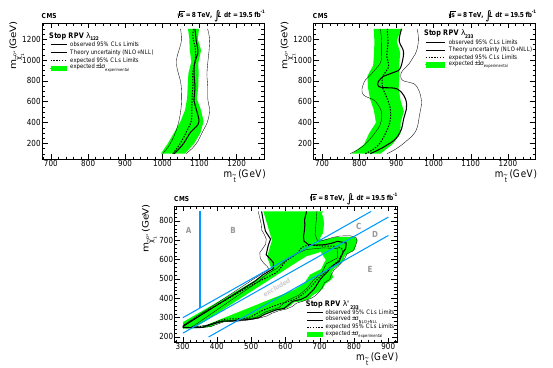
F igure 5. The 95% confidence level limits in the stop and bino mass plane for models with RPV couplings λ 122 , λ 233 , and λ (cid:48) . 233 For the couplings λ 122 and λ 233 , the region to the left of the curve is excluded. For λ (cid:48) , the region inside the curve is excluded. The 233 di ff erent regions, A, B, C, D, and E, for the λ (cid:48) exclusion result 233 from di ff erent stop decay products as explained in Table